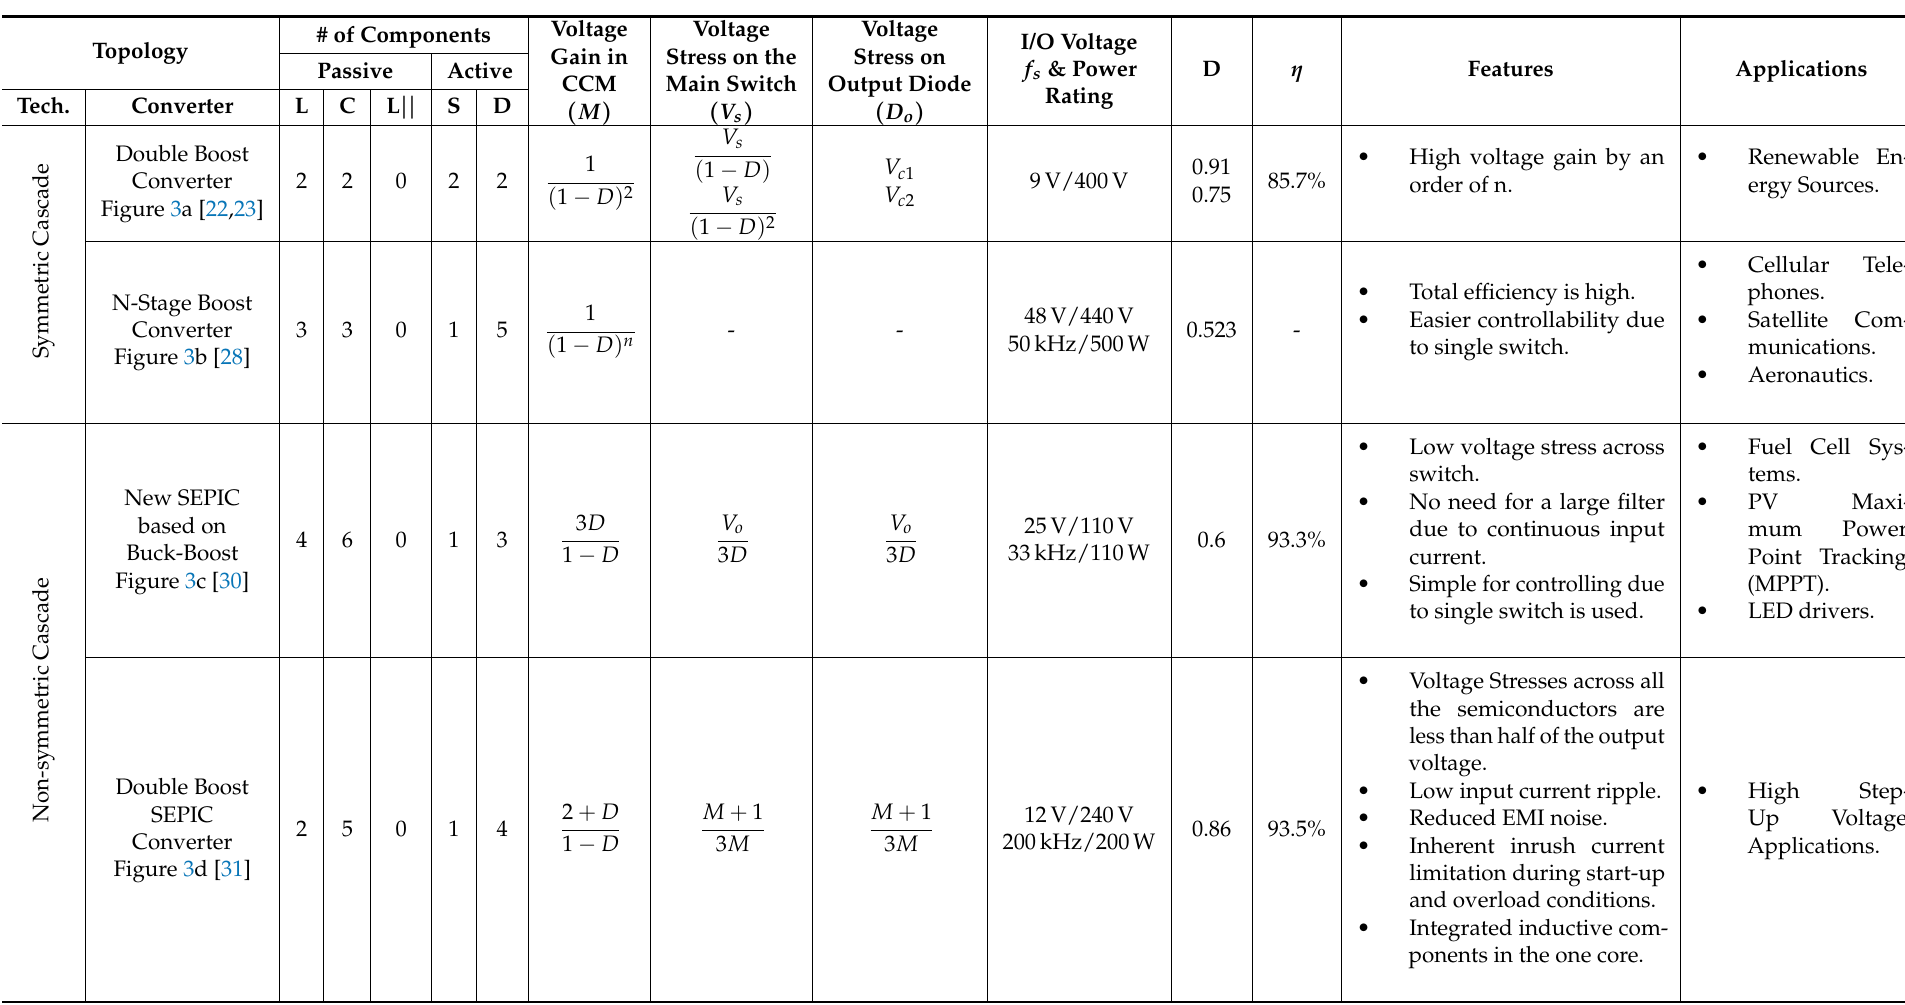
Table 1. Comparison of Cascaded Boost